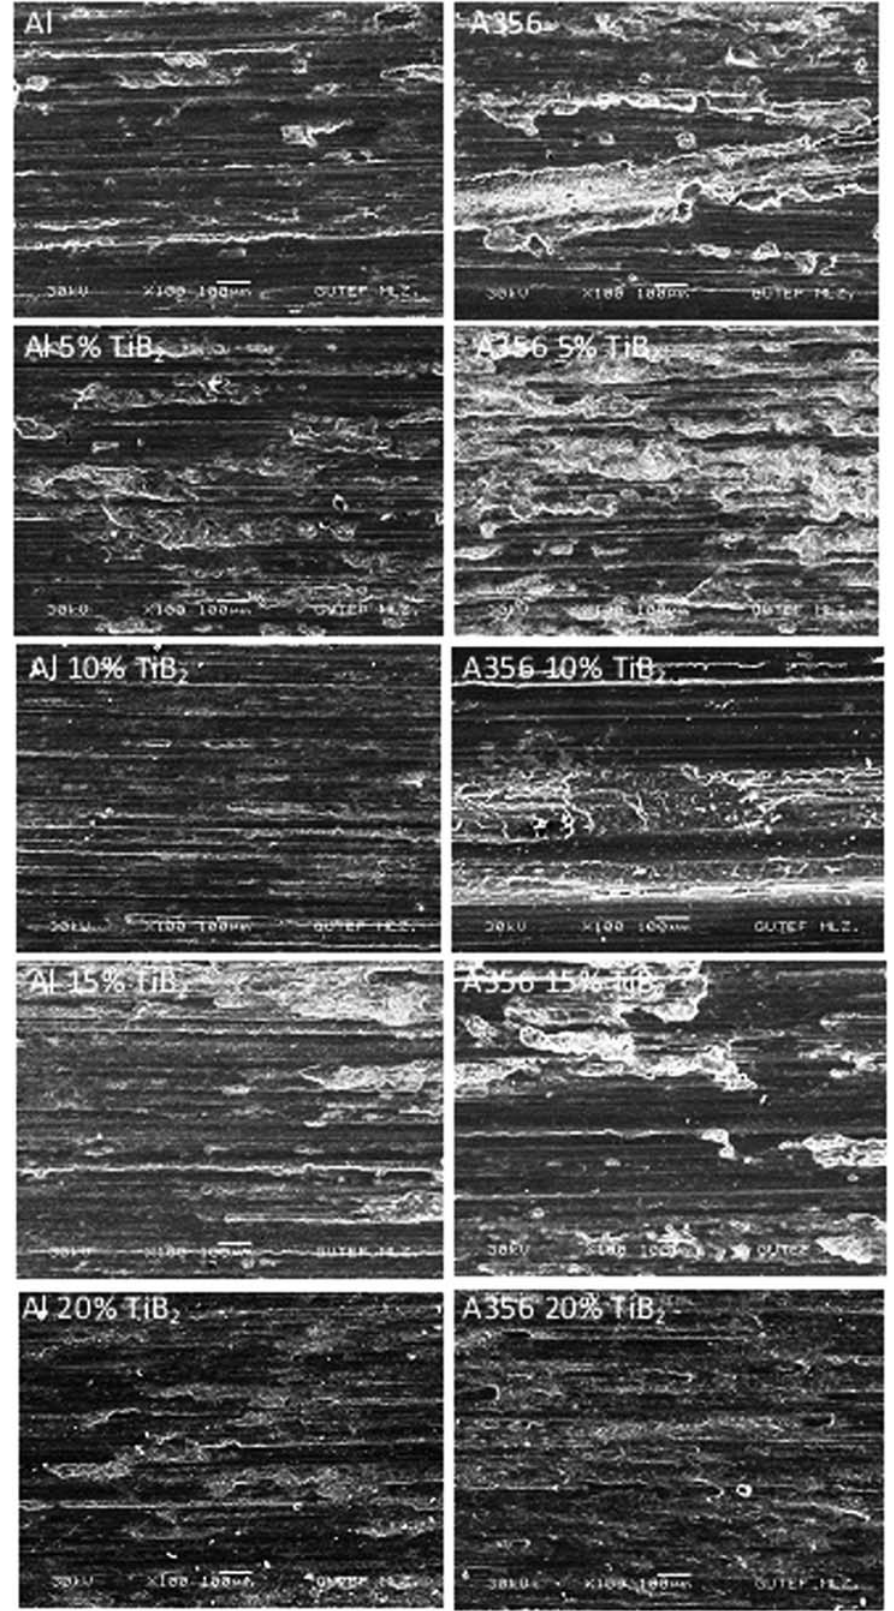
Figure 7 Wear surface SEM images of Al and A356 matrix composites for 50 N applied